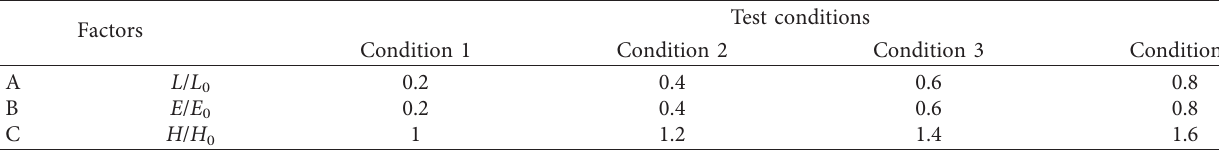
Figure 5: Schematic of the relationship between partition wall and foundation pit. Table 6: Main factors and levels of the orthogonal test.